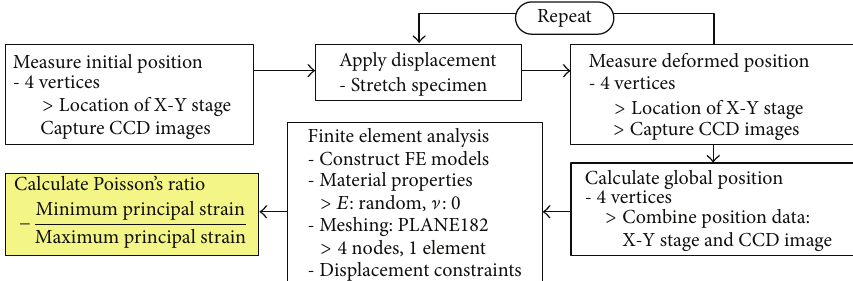
Figure 6: Procedure of Poisson’s ratio evaluation.